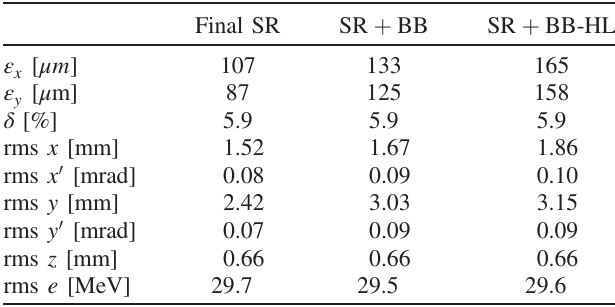
TABLE V. Beam parameters at the dump. The columns show the values for SR only, SR and beam-beam, and SR and beam- beam with the Higgs factory (high-luminosity)